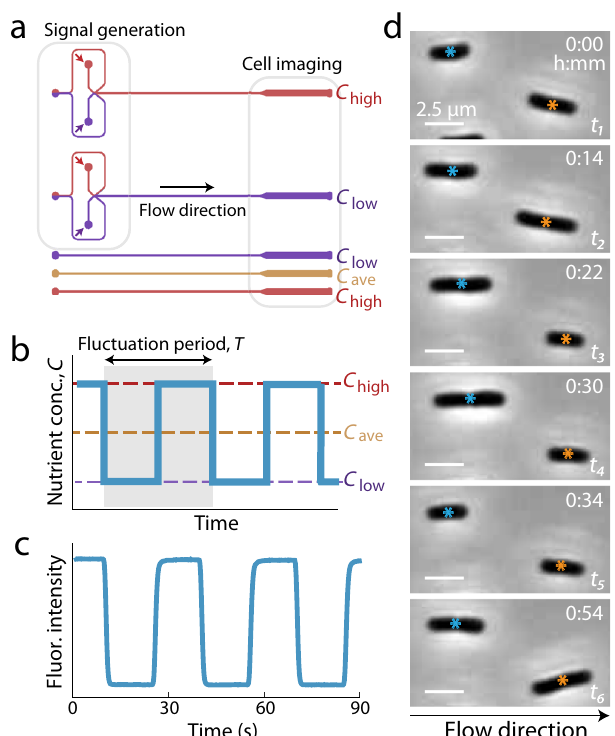
Fig. 1 The micro fl uidic signal generator (MSG) creates automated, precise high-frequency fl uctuations in nutrient concentration while enabling single-cell microscopy. a The two channel con fi gurations: the MSG switches between two media (top) and the straight channels each steadily deliver a single medium (bottom). Each experiment contains four parallel channels: one MSG and three straight. The two MSG channels displayed here schematically represent the fl ow conditions that deliver either C low or C high to the cells. The upstream portion of the MSG switches the nutrient media delivered to cells via automated control over the pressure differences driving each medium while maintaining a constant fl ow rate into the device. The top MSG delivers C high (red) to cells by pressurizing the red inlet higher than the C low (purple) inlet. The wider downstream section fi ts over ten imaging fi elds of view at ×60 magni fi cation. b Bacteria were exposed to fl uctuating signals in the form of even oscillations between a low and a high LB concentration ( C low and C T , between 30 s and 60 min. Three control high ), with periods, environments, C low , C ave , and C high , were run simultaneously with each fl uctuating environment. c Fluorescence intensity, from fl uorescein added to one of the media, illustrates the signal received at the cell imaging region over multiple oscillations ( T = 30 s). Transitions between media are completed in <3 s. d Individual E. coli cells growing within the MSG. Cells were imaged at 117 s intervals; timestamps of selected images are displayed in minutes. Cells divide between t 2 and t 3 (orange) and between t 4 and t 5 (blue), and can be seen elongating between other frames. One of the two cells emerging from division is swept away with the fl ow. Images were cropped from one steady nutrient experiment and are representative of the growth behaviors observed in all experiments described in this paper. To isolate the role of nutrient timescale from that of nutrient concentration, we switched between the same two nutrient concentrations for all fl uctuating environments, a high and a low concentration of a complex growth medium ( C high = 2% LB, C low = 0.1% LB), empirically chosen to avoid the saturation of growth rate (Supplementary Fig. 5a, b). Three control experi- ments with steady nutrient concentrations were run in parallel with each fl uctuating experiment: one at C high , one at C low , and one at C ave = ( C high + C low )/2 (i.e., 1.05% LB) (Fig. 1a). We found NATURE COMMUNICATIONS| (2021) 12:3662